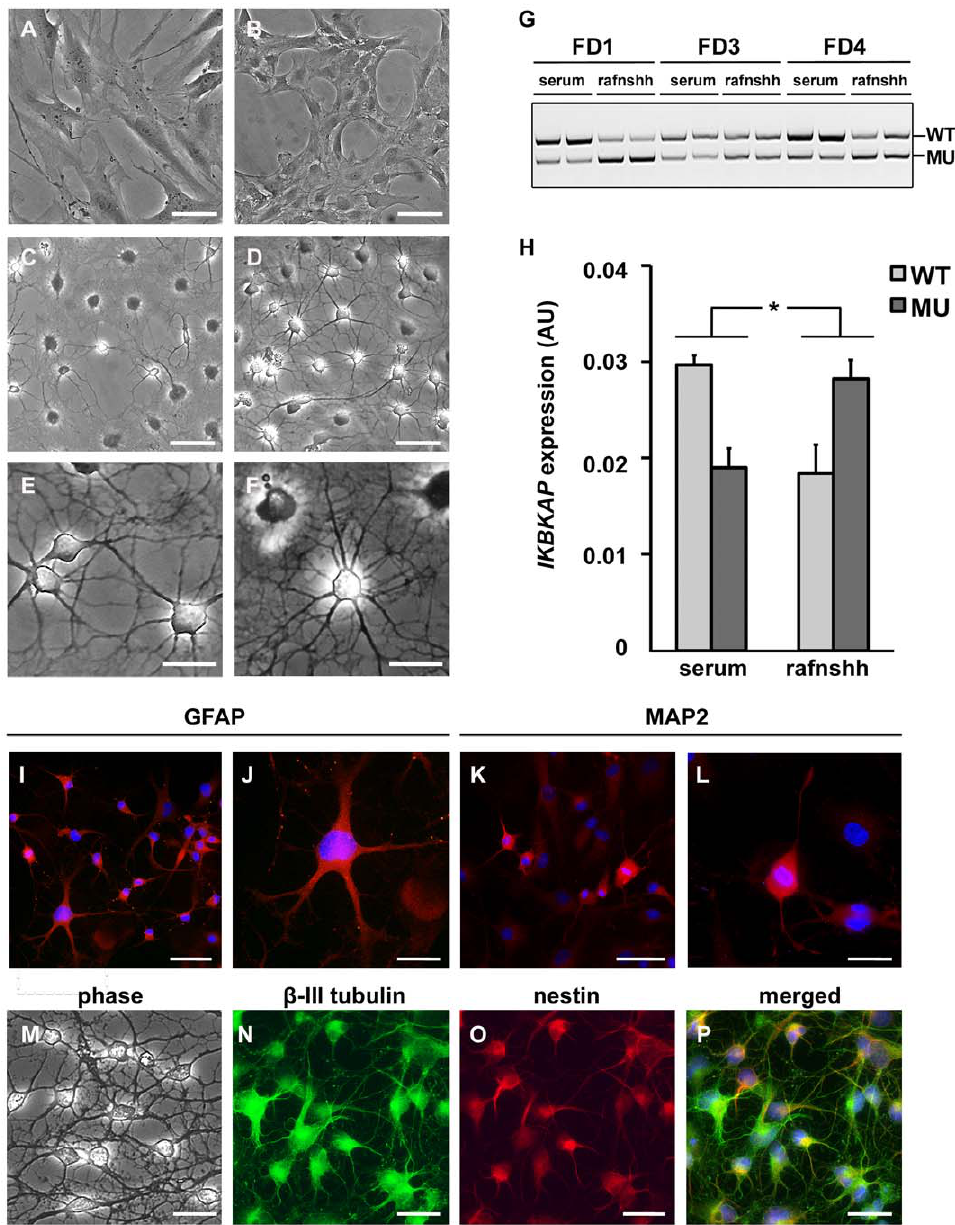
Figure 9. WT:MU ratio is decreased in differentiated hOE-MSCs. A, Phase contrast microscopy of FD hOE-MSCs cultured for 48 h in either serum (A), or N2B27 conditions (B), or with the rafnshh cocktail including retinoic acid, forskolin and Sonic hedgehog (C), or rafnshh for 7 days (D). Details of connections established between cells and extensive cellular arborization after 7 days in rafnshh condition are shown in E and F. G, agarose gel electrophoresis of semi-quantitative RT-PCR products showing IKBKAP WT and MU transcripts of 3 differents FD patients before and after rafnshh treatment. H, histograms represent the mean level of IKBKAP transcripts expression normalized with ABL1 gene expression for 3 FD patients, after RT- qPCR analysis. (* P , 0,05, using two-tailed Student’s test). FD hOE-MSCs treated for 7 days in rafnshh were fixed and stained for GFAP (I, one cell with ramified neuritic process is magnified in J), MAP2 expression (K and L). M–P, double labelling of rafnshh-treated cells with anti- b III tubulin and anti- nestin antibodies. Scale bars represent either 50 m m (A–D, I, K, M–P) or 25 m m (E–F, J,